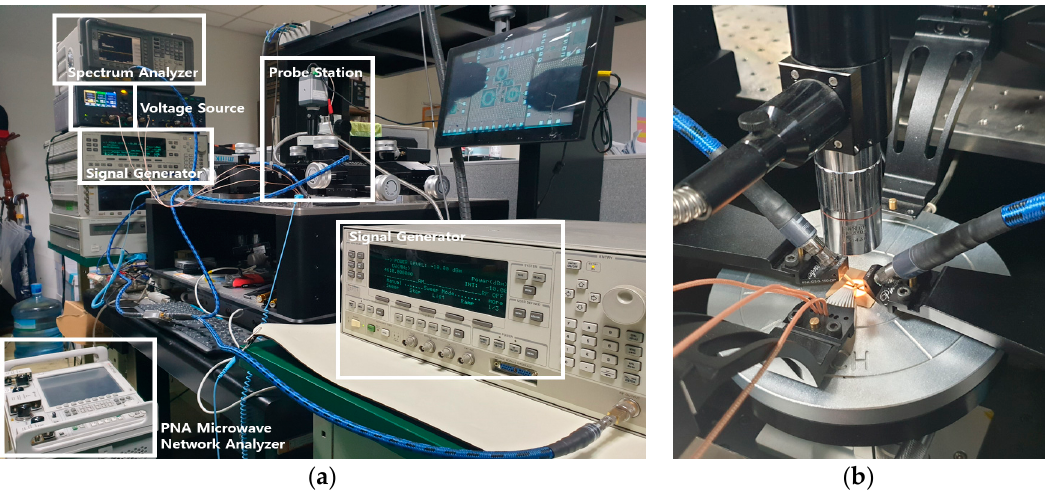
Figure 5. ( a ) Measurement and ( b ) probing setup of the proposed PA.